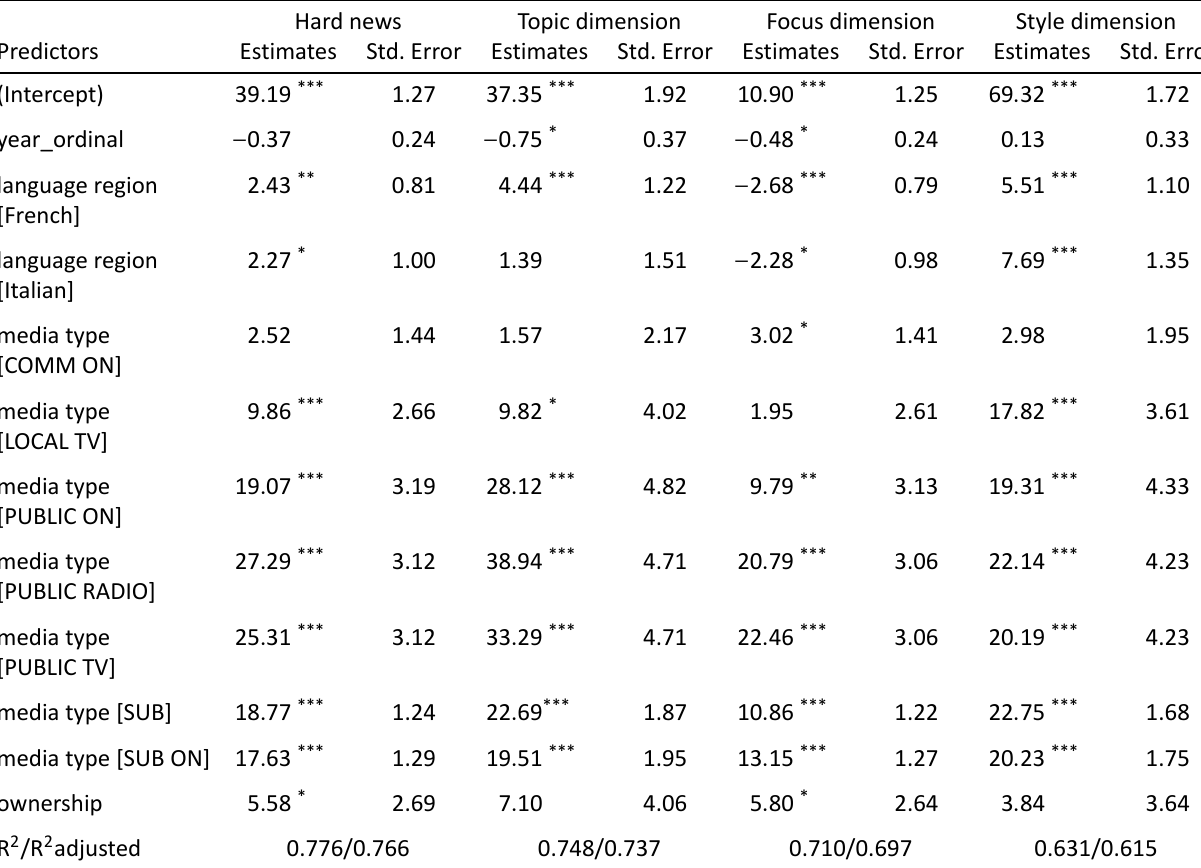
Table 5. Model predicting (dimensions of) hard news